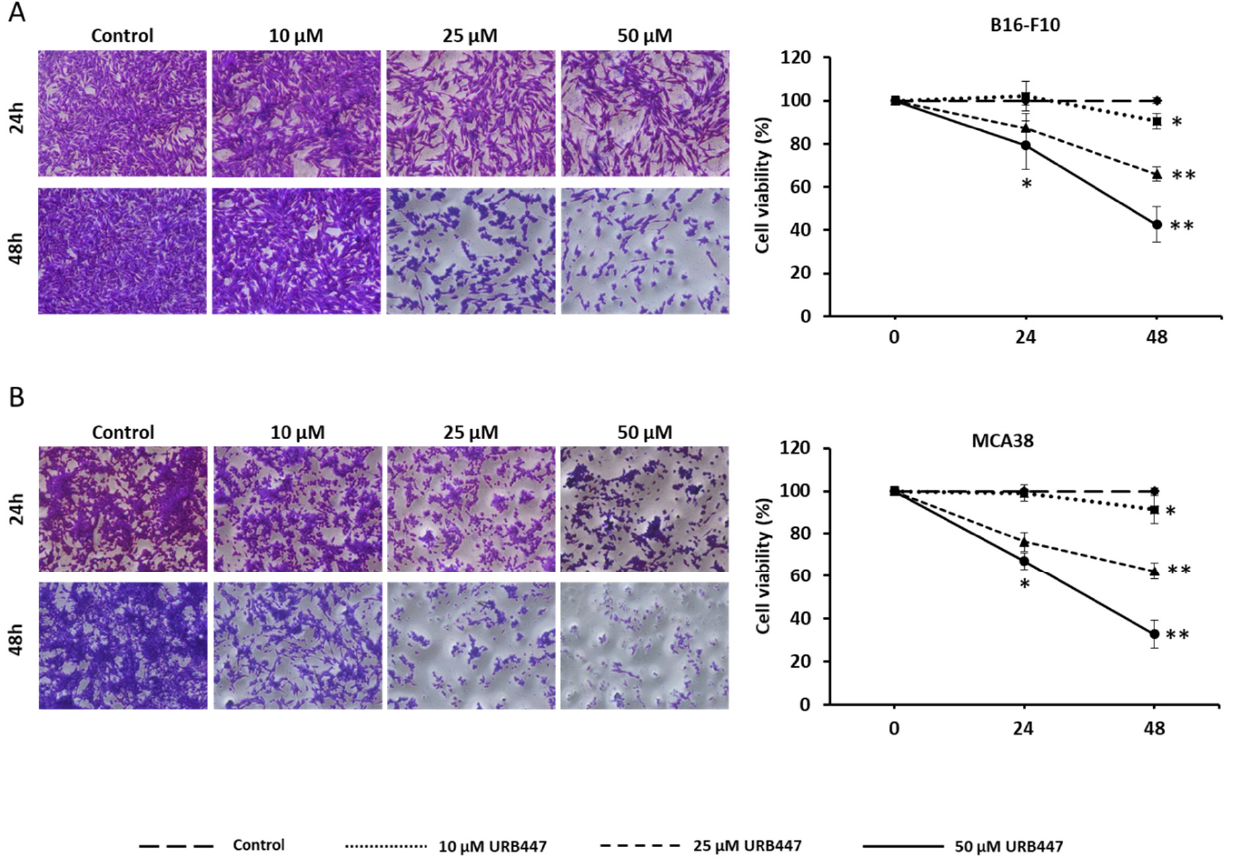
Figure 2 . Tumor cell viability upon treatment with URB447. Melanoma ( A ) and CRC cancer cells ( B ) were incubated in the presence of URB447 for 24 and 48 h. Cell viability was measured using Prestoblue™ viability assay. Images show representative cell population at the time of the measurement ( n = 3). Differences were considered statistically significant for * p < 0.05, ** p < 0.01 using Student t test.